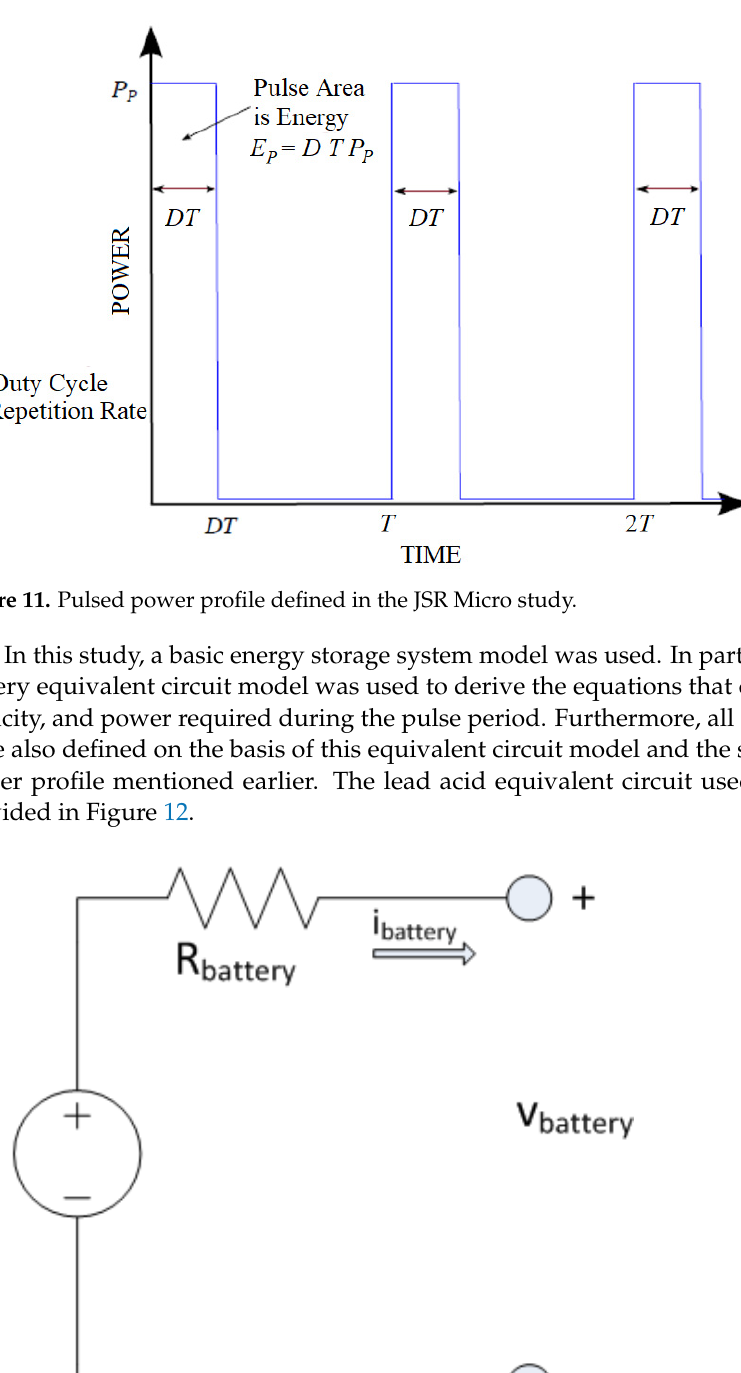
Figure 12. Lead acid battery electrical circuit equivalent model.